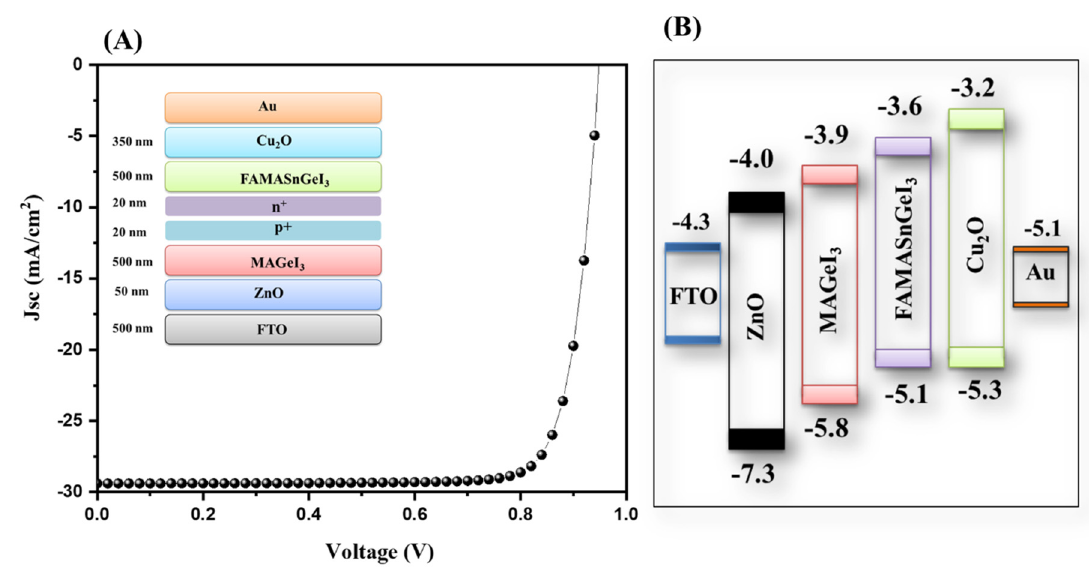
Figure 10. J–V curve ( A ) and energy level diagram ( B ) of tandem solar cells with ZnO as the ETL. The J–V characteristic of the ZnSe-ETL-based tandem solar cells is presented in Figure 11A.